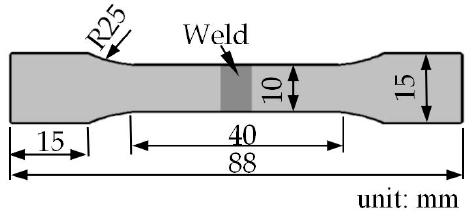
Figure 4. Shape and dimensions of tensile specimens.